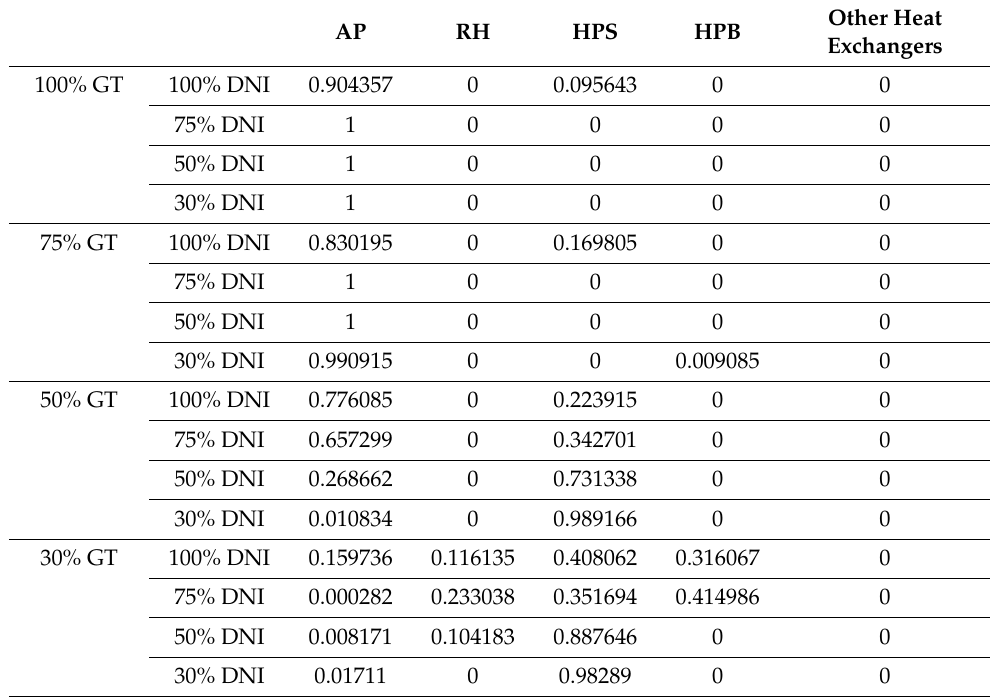
Table 7. The integration proportions of different work conditions based on the maximum system